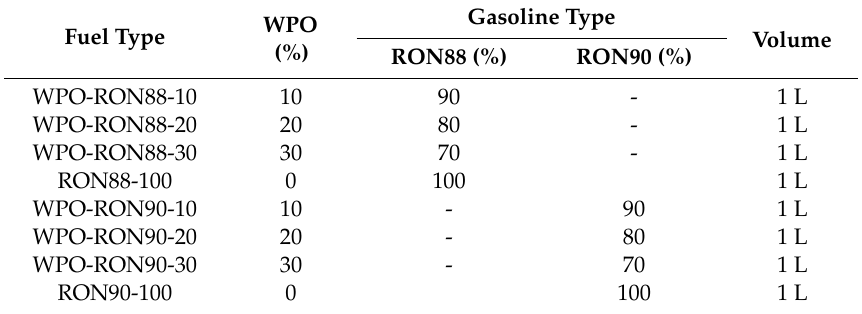
Table 1. Preparations of fuel samples of waste oil plastic blend with gasoline (RON88 and RON90).